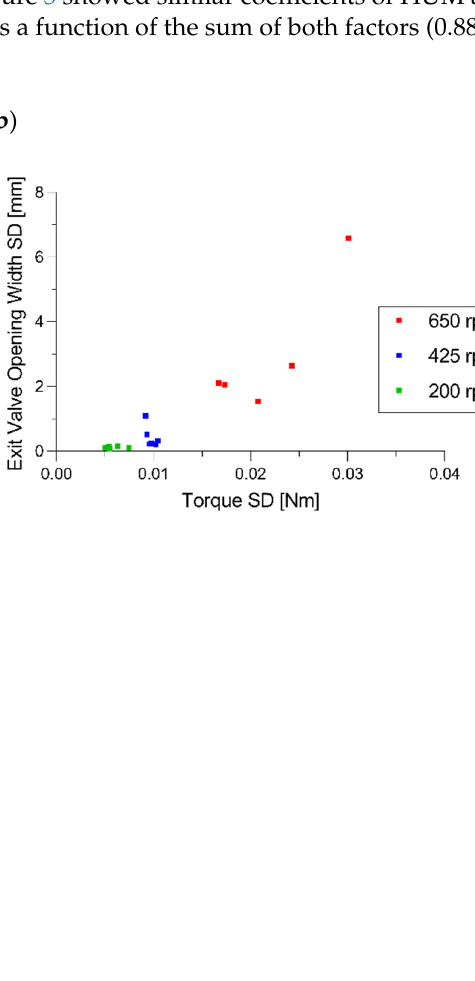
Figure 14. ( a ) Torque of the lower impeller as a function of the sum of HUM and IMP. ( b ) Correla- tion between variability in torque and exit valve opening width. ( c ) Impact of impeller speed on the torque values.